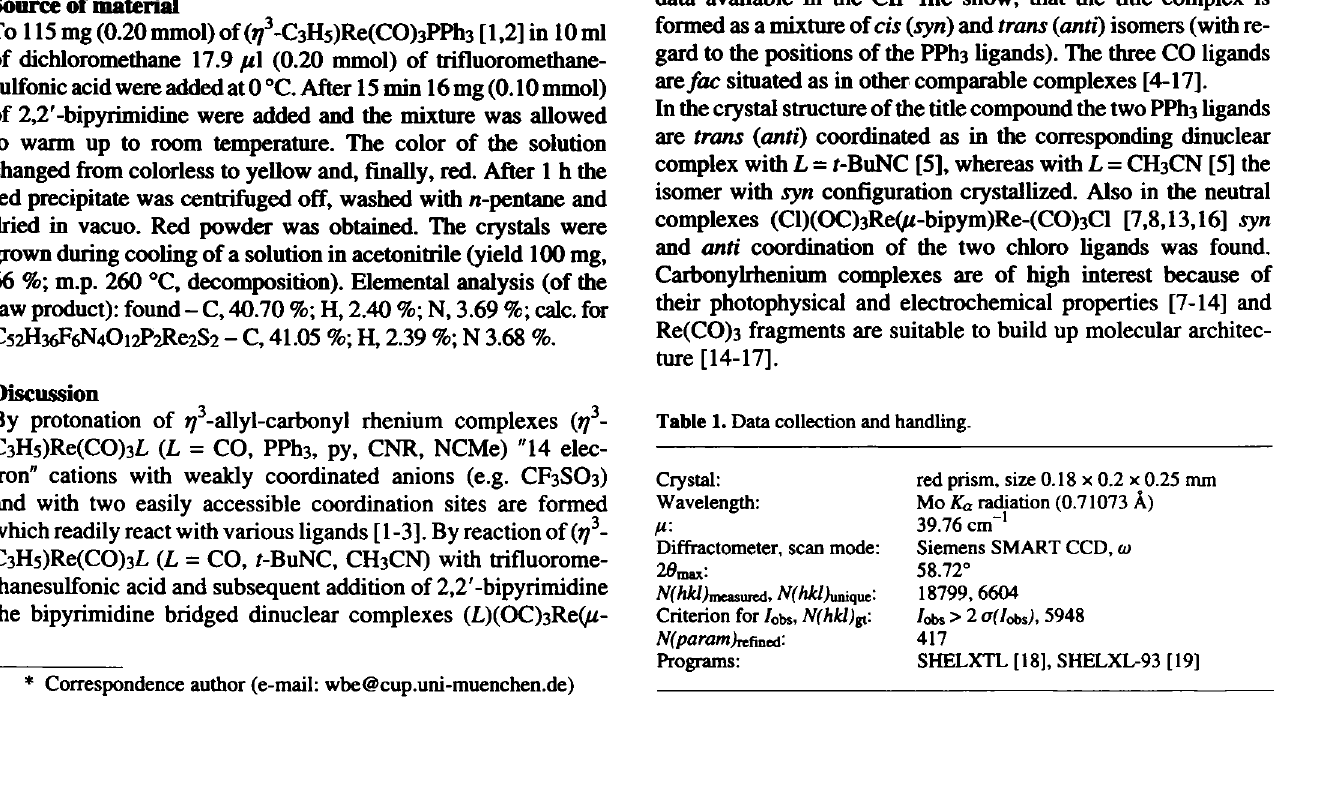
C6oH48F6N Oi2P2Re2S2, monoclinic, P12i/cl (no. 14), 8 a = 12.980(1) A, b = 18.117(1) A, c = 14.437(1) A, β = 109.41(1)°, V= 3202.0 A 3 ,Z= 2, R#(F) = wRoUF 2 ) T= 0.026, = 0.055, 193 K.